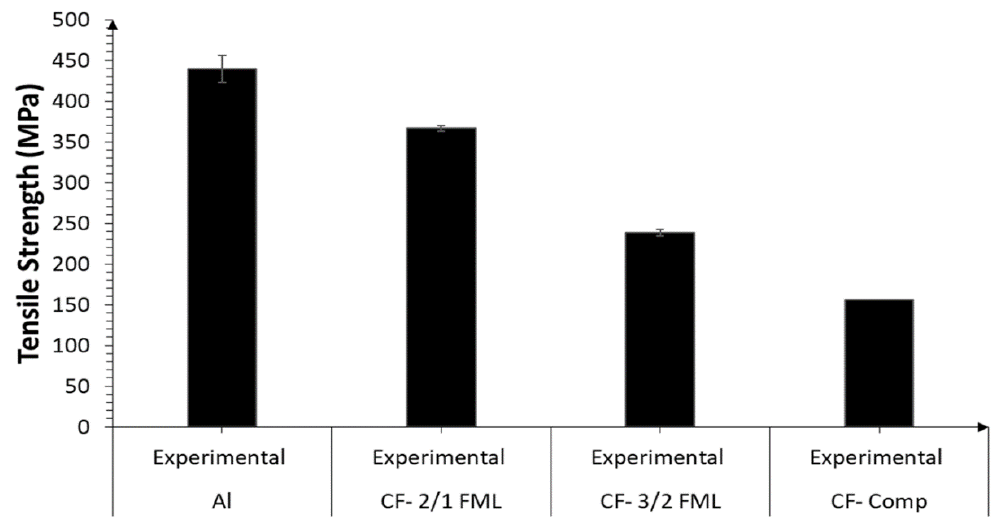
Figure 6. Tensile strength of the CF-FMLs and its constituent materials.